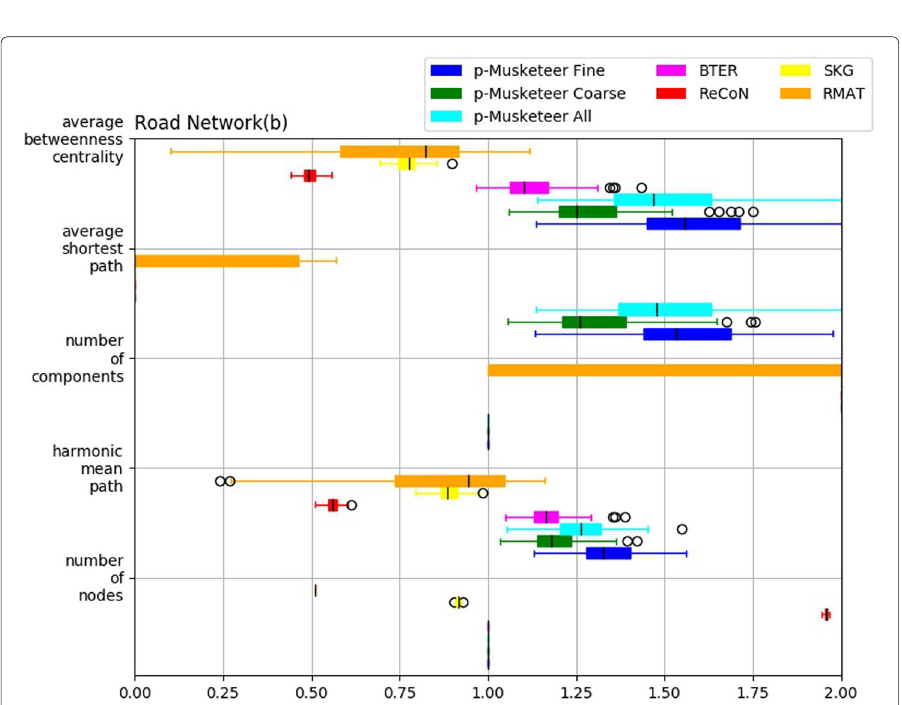
Fig. 9 Computational results on performance of planar Musketeer on road network from roadNet-TX with 2001 nodes and 2957 edges for number of nodes, harmonic mean path, number of components, average shortest path and average betweenness